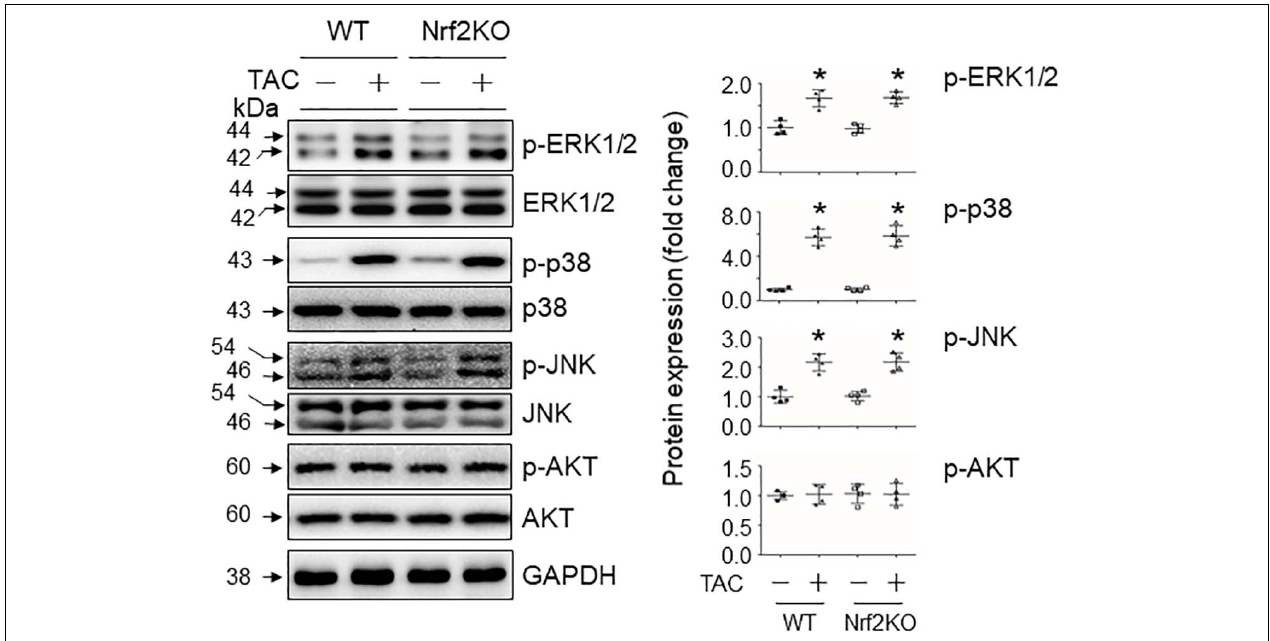
FIGURE 4 | The impact of Nrf2 knockout on pressure overload-induced activation of MAPKs and AKT in the heart. Male WT and Nrf2 knockout (Nrf2KO) mice at age of 9 ∼ 10 weeks were subject to sham or TAC operations for 4 weeks and then left ventricles of these mice were harvested for Western blot analyses of MAPKs and AKT activities ( n = 4). * p < 0.05 vs TAC (–) in the same groups using the Student t test; p < 0.01 between the indicated groups using one-way ANOVA followed by Bonferroni